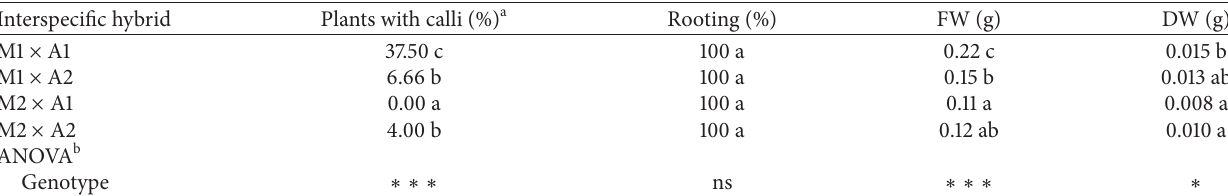
Table 4: Rooting ability of S. melongena × S. aethiopicum interspecific hybrid plantlets in basal medium (MB) measured as frequency of rooting, frequency of plants with calli, and fresh weight (FW) and dry weight (DW) at 30 days of culture. Interspecific hybrid Plants with calli (%) a